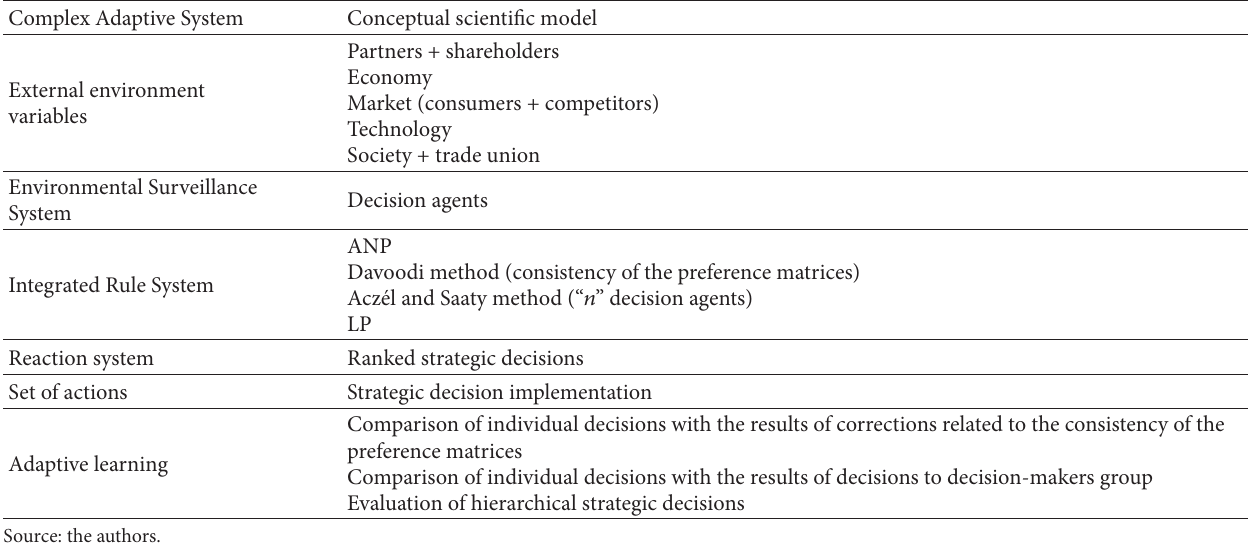
Table 1: Relationships between CAS and the conceptual scientific model.